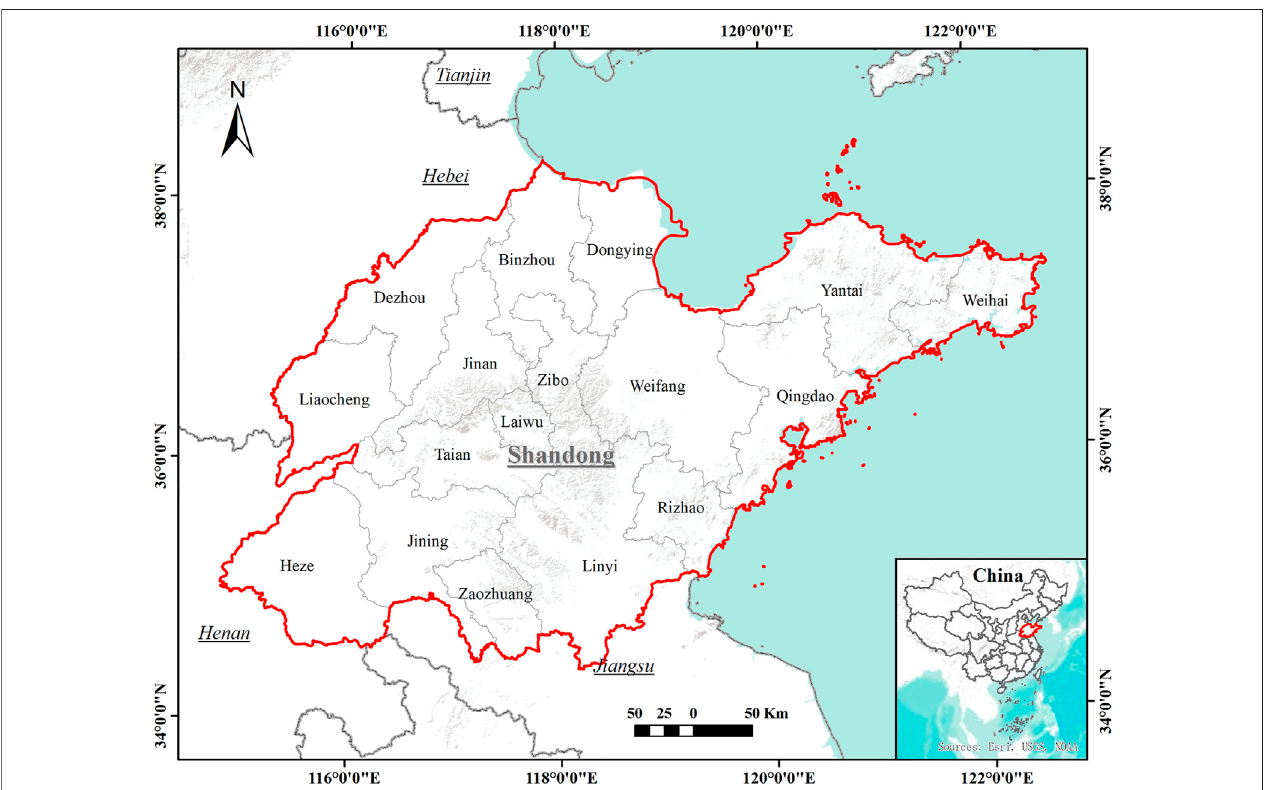
FIGURE 1 | Study area (modi fi ed it from Ou et al.,